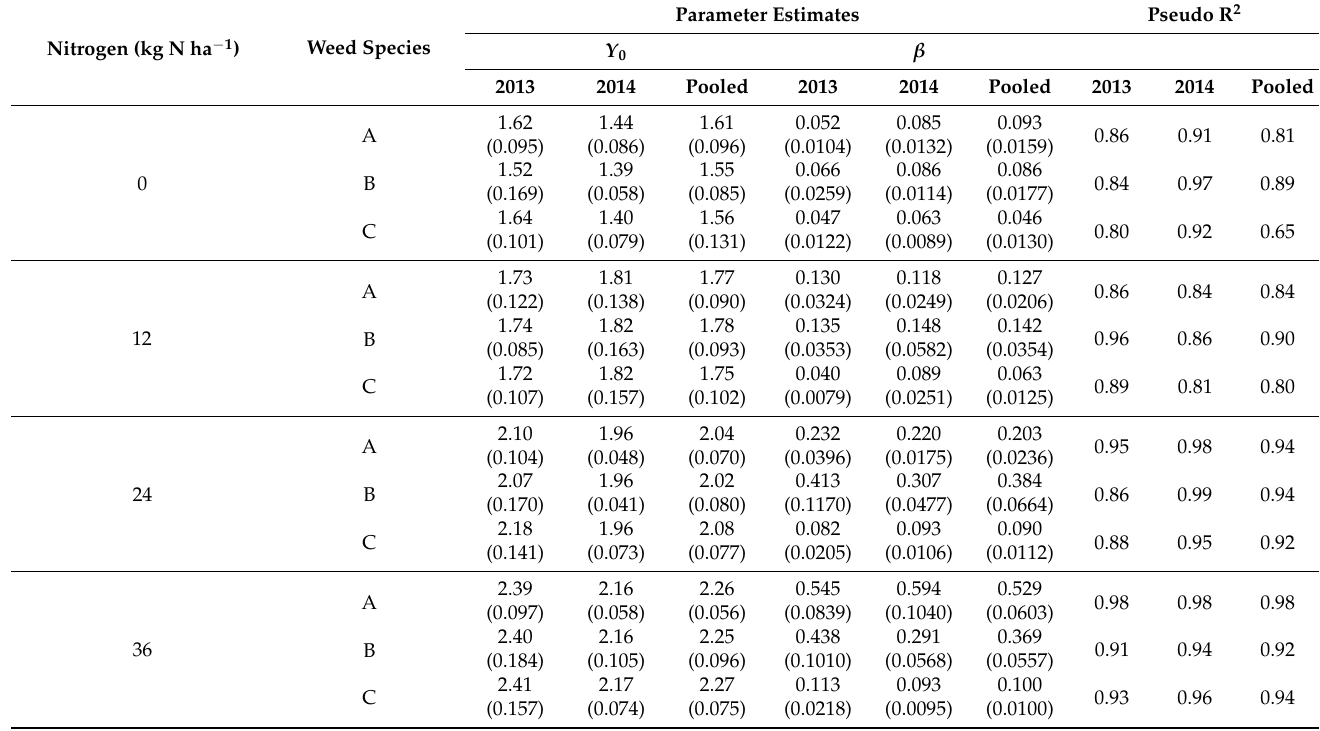
Table 1. Parameter estimates for the rectangular hyperbolic model for the regression of soybean yield as a result of single- weed interference caused by Ambrosia artemisiifolia (A), Echinochloa crus-galli (B), and Beckmannia syzigachne (C) at different nitrogen levels in 2013 and 2014 and for the pooled two-year data. The numbers in parentheses are standard errors.